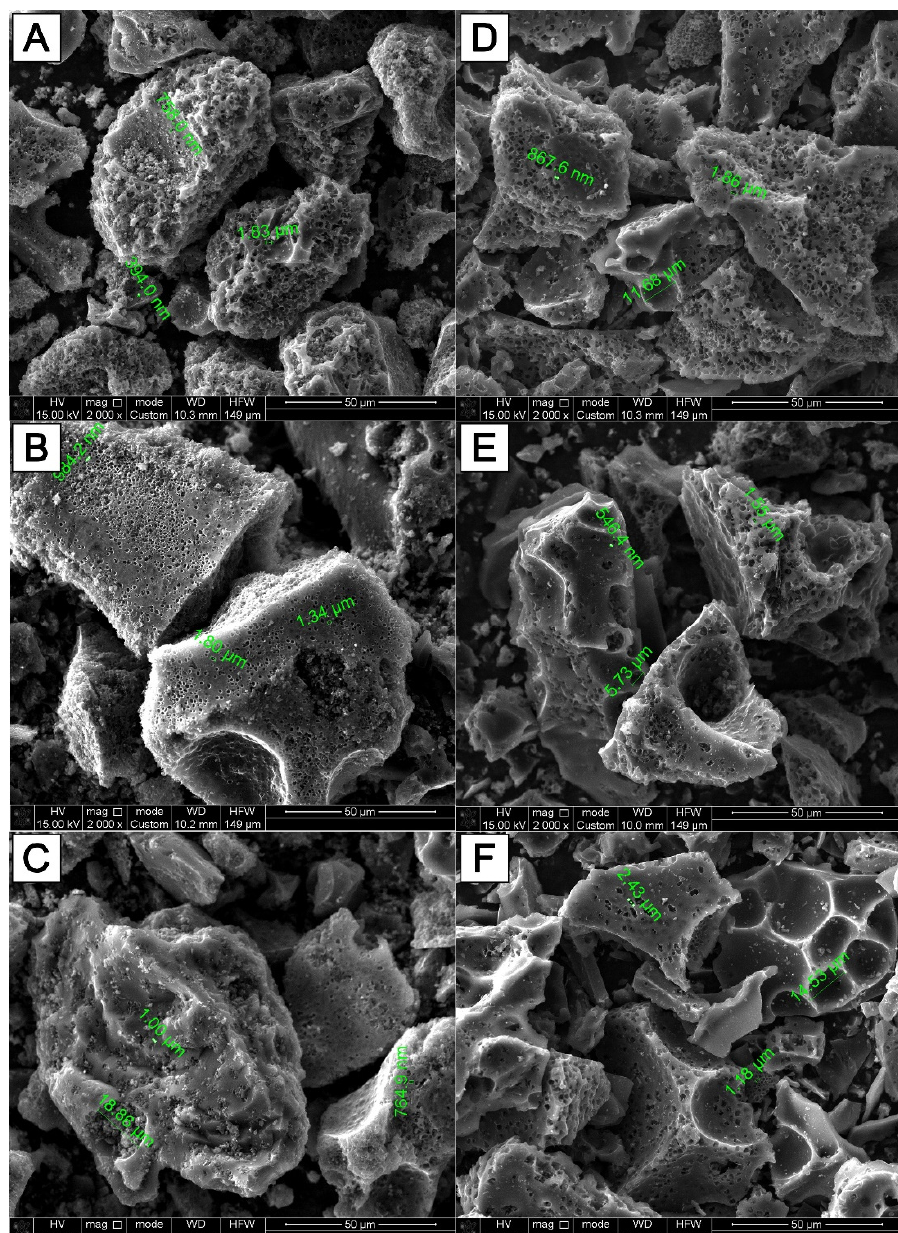
Figure 1. SEM images of carbon materials activated at different temperatures. ( A ) AKS-700 ◦ C; ( B ) AKS-800 ◦ C; ( C ) AKS-900 ◦ C; ( D ) APS-700 ◦ C; ( E ) APS-800 ◦ C; ( F ) APS-900 ◦ C.